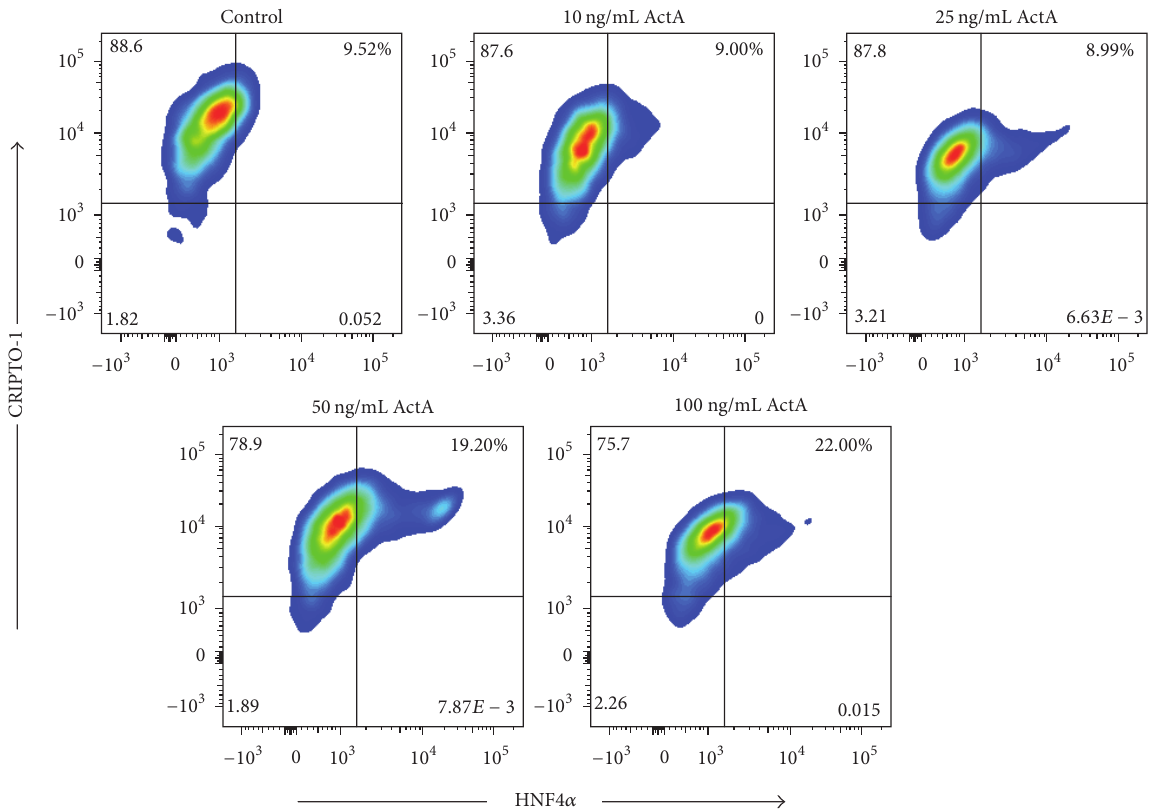
Figure 6: CRIPTO-1 and HNF4 𝛼 expression profiles in ActA treated human ESCs during early cardiac differentiation. HNF4 𝛼 + endodermal- like cells had a higher expression level of CRIPTO-1 in the control and 50 and 100ng/mL ActA condition compared to the 10 and 25 ng/mL ActA treatment. Flow cytometry analyses of HNF4 𝛼 and CRIPTO-1 expression after induction of human ESC-CM differentiation with the indicated concentrations of ActA. Representative example of three independent